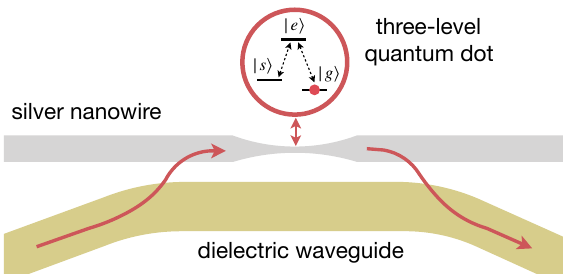
Figure 4. The design of a single-photon transistor. Reproduced from [92] with the permission. SPP modes on a silver nanowire are used to provide a strong coupling between the three-level quantum gate and waveguided photons. The gate works as a single-photon memory device controlled by the external optical field. The transparency of the transistor for the incoming signal depends on the quantum sate of the